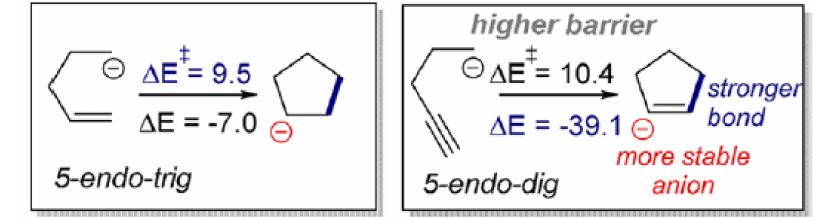
Figure 34. Comparison of alkene and alkyne reactivities in terms of kinetics and thermodynamics (reproduced with permission from [339]. Copyright 2018 American Chemical